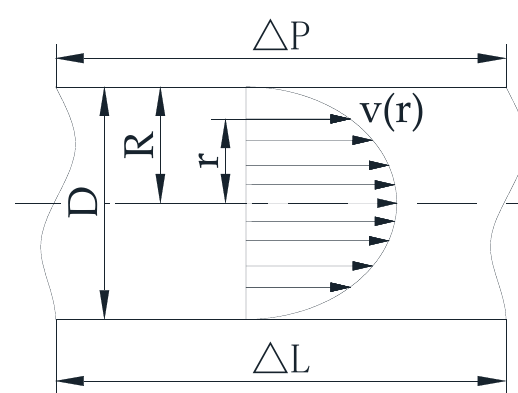
Figure 5. The velocity profile in pipe laminar flow.